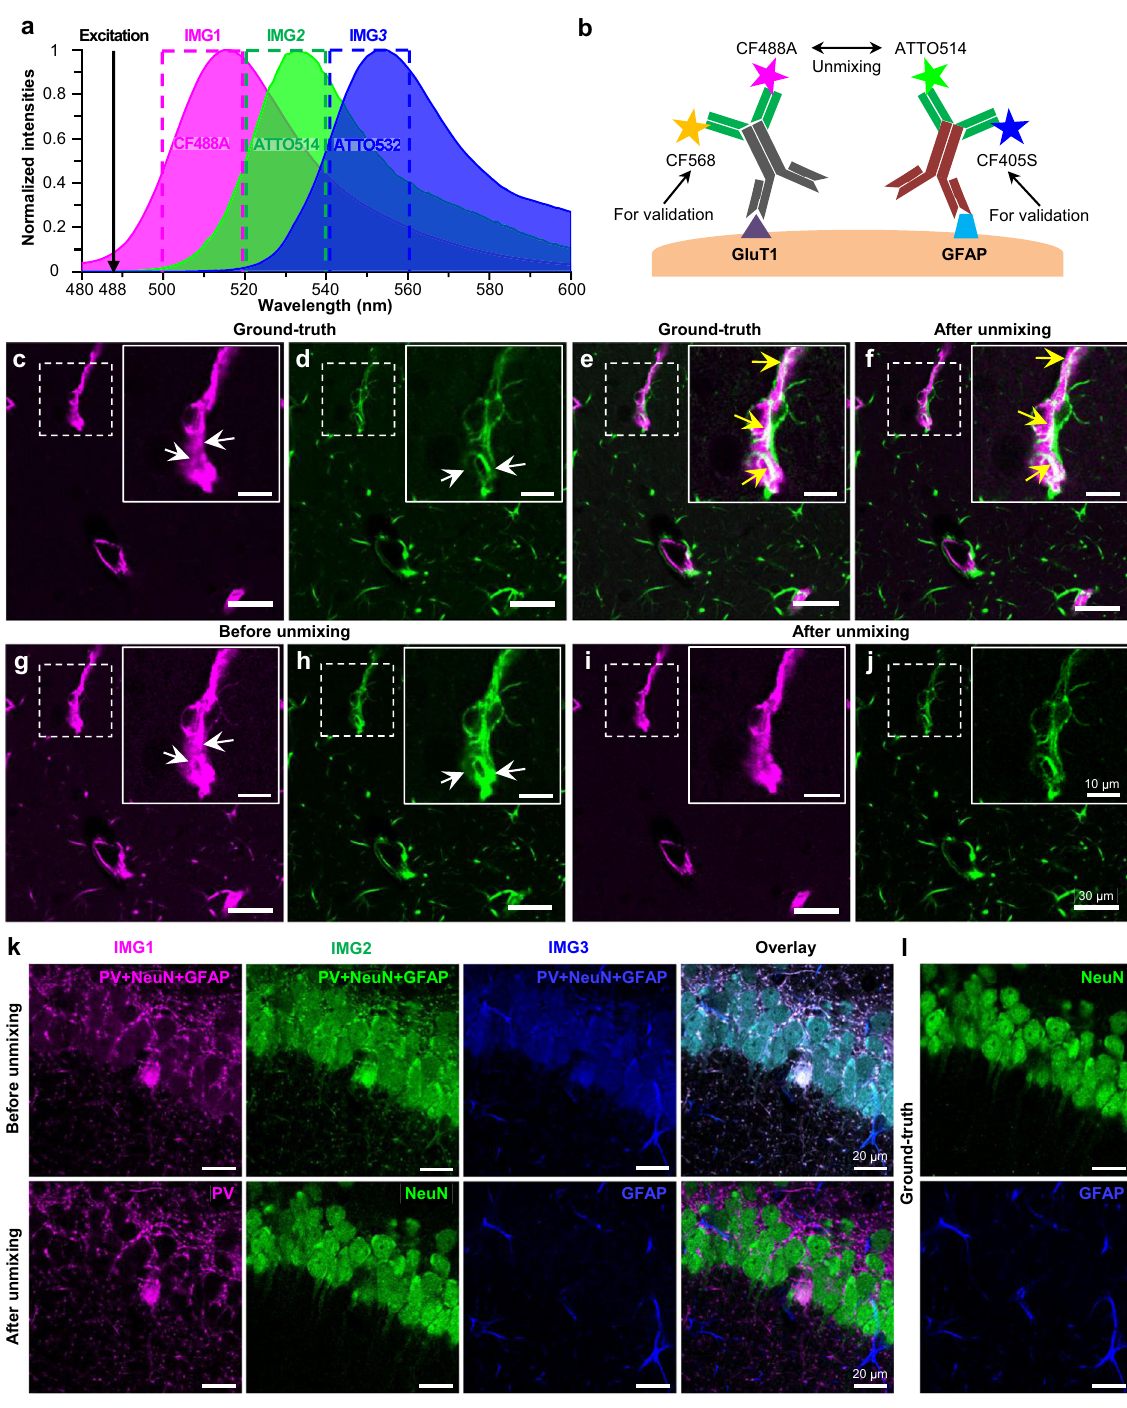
Fig. 3 Experimental validation of unmixing of spatially overlapping proteins using PICASSO. a Emission spectra of the three fl uorophores and three detection channels used in this experiment. The solid line and shaded area: emission spectrum of each fl uorophore. Dotted box: detection channel from where images were acquired. In the two-channel validation experiment shown in c – j , only CF488A and ATTO514 were used and images were acquired from the fi rst two detection channels. In the three-channel validation experiment shown in k , l , all three fl uorophores and detection channels were used. b Schematic of two-channel validation experiment. c – j Ground-truth, before unmixing, and after unmixing images of the two-channel validation experiment. c First channel of the ground-truth image, showing GluT1. d Second channel of the ground-truth image, showing GFAP. e Overlay of the two channels of the ground-truth image. f Overlay of the two channels of the after-unmixing image. g First channel of the mixed image, acquired from the fi rst detection range in a . h Second channel of the mixed image, acquired from the second detection range shown in a . i First channel of the unmixed image, showing GluT1. j Second channel of the unmixed image, showing GFAP. k , l Ground-truth, before unmixing, and after unmixing images of the three-channel validation experiment. k Before and after unmixing images. l Ground-truth images stained with separate antibodies against NeuN and